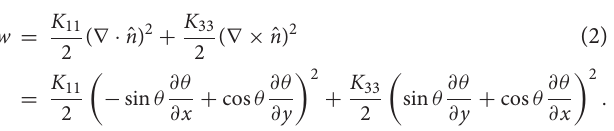
FIGURE 2 | Sketches of topological defects with strengths top row images), left: “radial,” right: “tangential” configuration. For all defects of strengths S S ). The half-integer defects are prohibited in vector fields such as the an angle θ 1 / (1 −